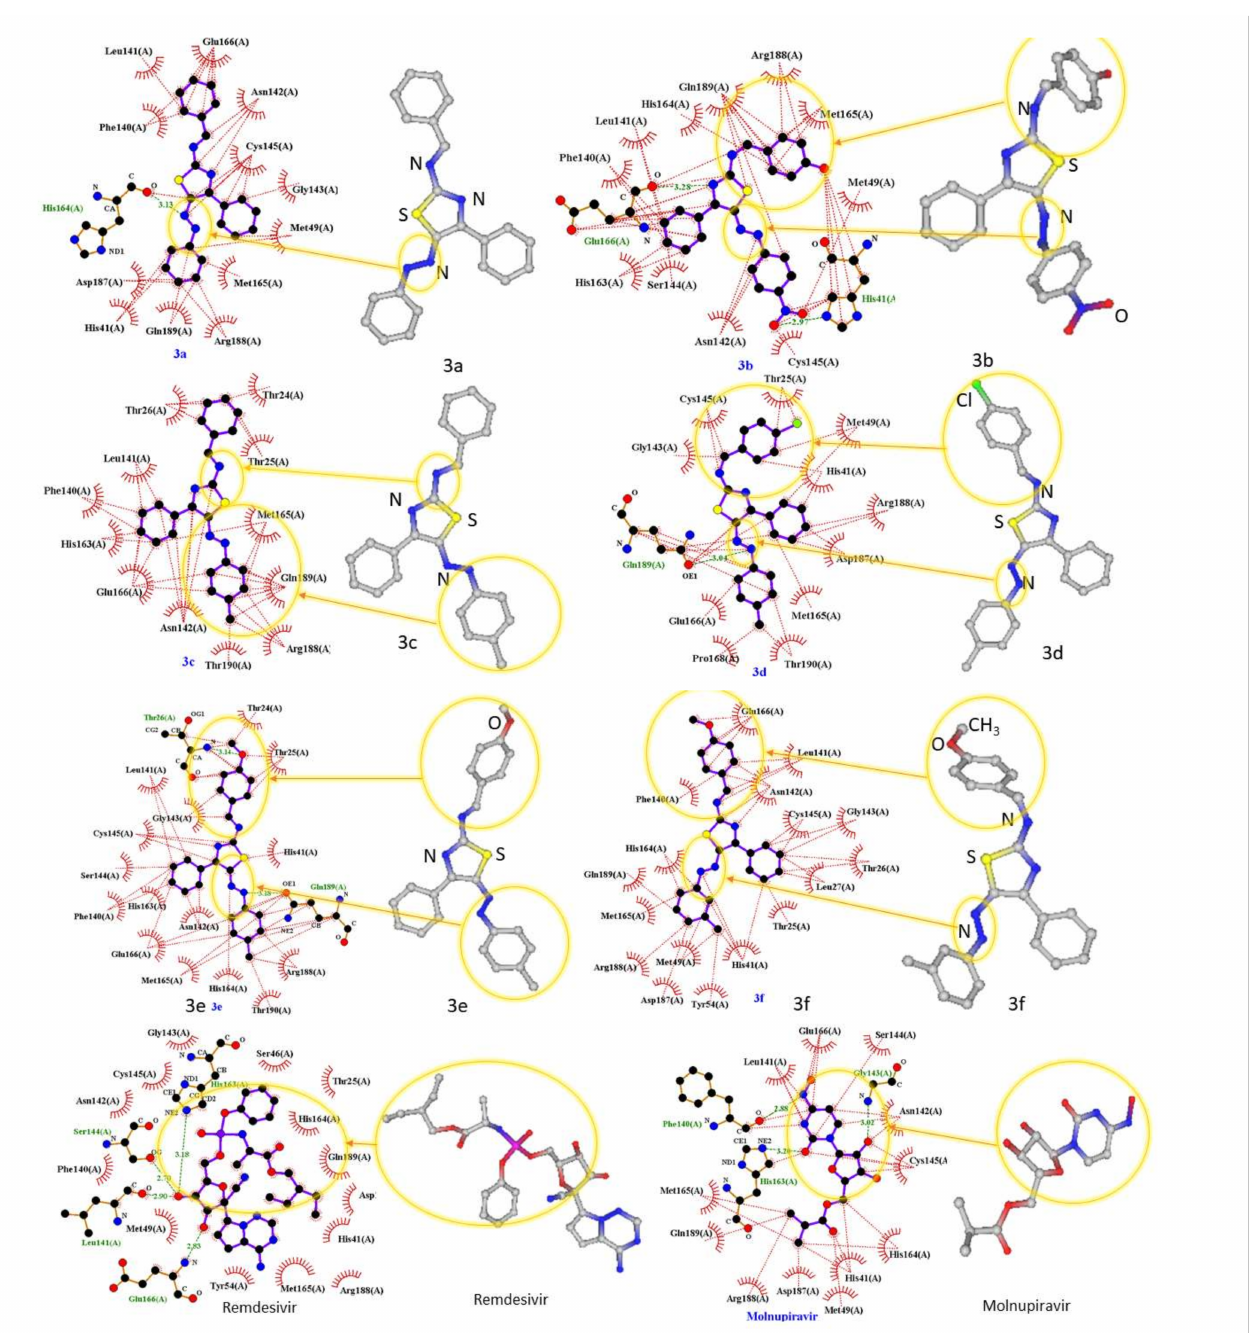
Figure 1. A schematic 2D LIGPLOT (LIGPLOT software is a program to generate schematic diagrams of protein-ligand interactions) representation showing 3a–f , Remdesivir, and Molnupiravir before and after docking into the binding pocket of 7BQY. The variations in the ligands are highlighted by yellow